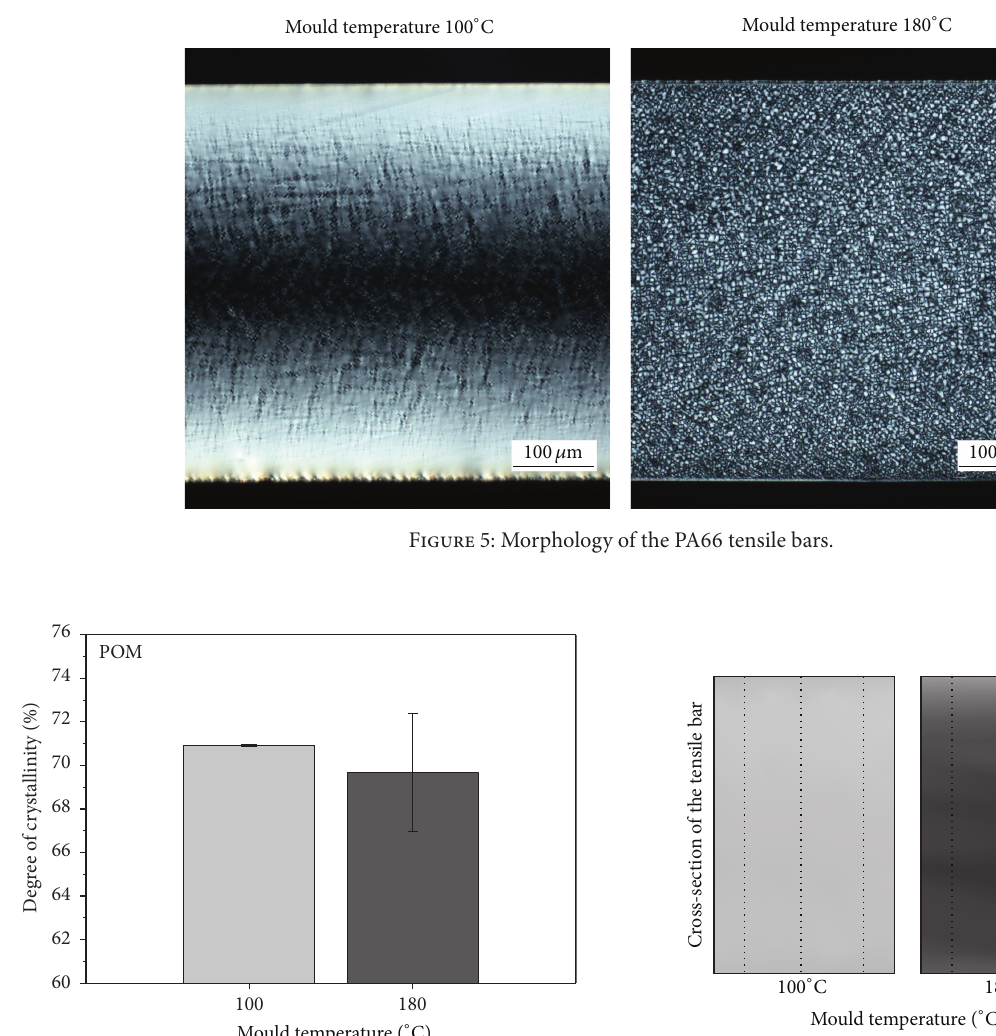
Figure 7: Degree of crystallinity in PA66 in the middle of the tensile bars with respect to the mould temperature (3 measuring points in the flow direction and 15 measuring points across the thickness with a measuring area of 200 × 20 𝜇 m). show no significant variation in the measured modulus. Only the deviation of the tensile modulus is distinctly higher